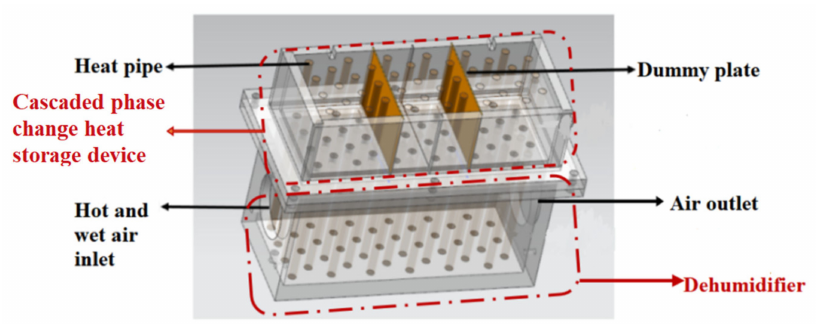
Figure 3. Structural diagram of a cascaded phase change heat storage